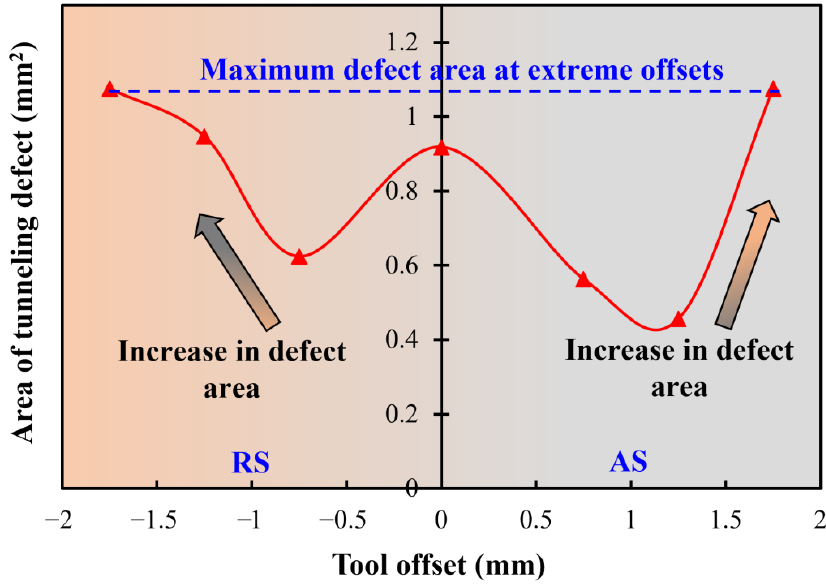
Figure 4. Variation of tunnelling defect area with tool offset.